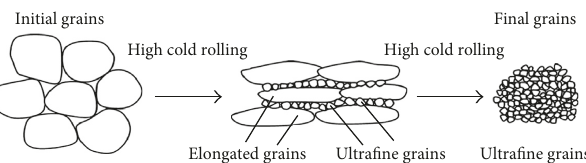
Figure 6: The evolution model of the deformation-induced grain subdivision during HSCRB